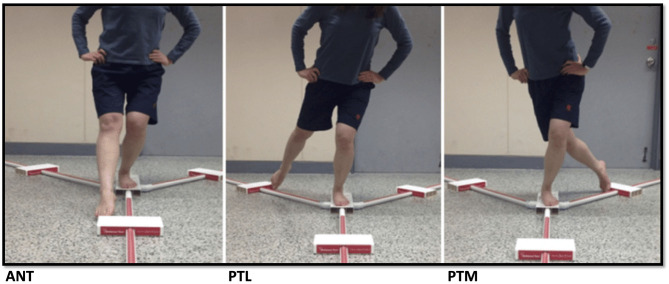
Illustration of the single leg Y-balance test (YBT) in the anterior (ANT), posterior lateral (PTL), and posterior medial (PTM) directions. Injury risk indicators were NCOMP reach deficiency (total reach <94% of limb length*3), NANT reach deficiency (ANT reach distance <84% leg length), and segmental comparisons >4.0 (Plisky et al., 2006; Gonell et al., 2015; Stiffler et al., 2017).